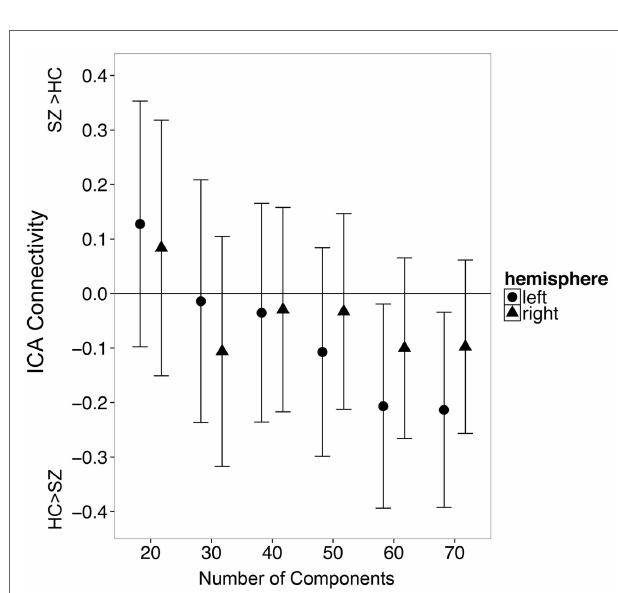
Figure 5 | The number of independent components specified during single subject ica influences apparent group differences in functional connectivity between the hippocampus and the default mode network . Error bars indicate 95% confidence interval of the between group difference in connectivity.